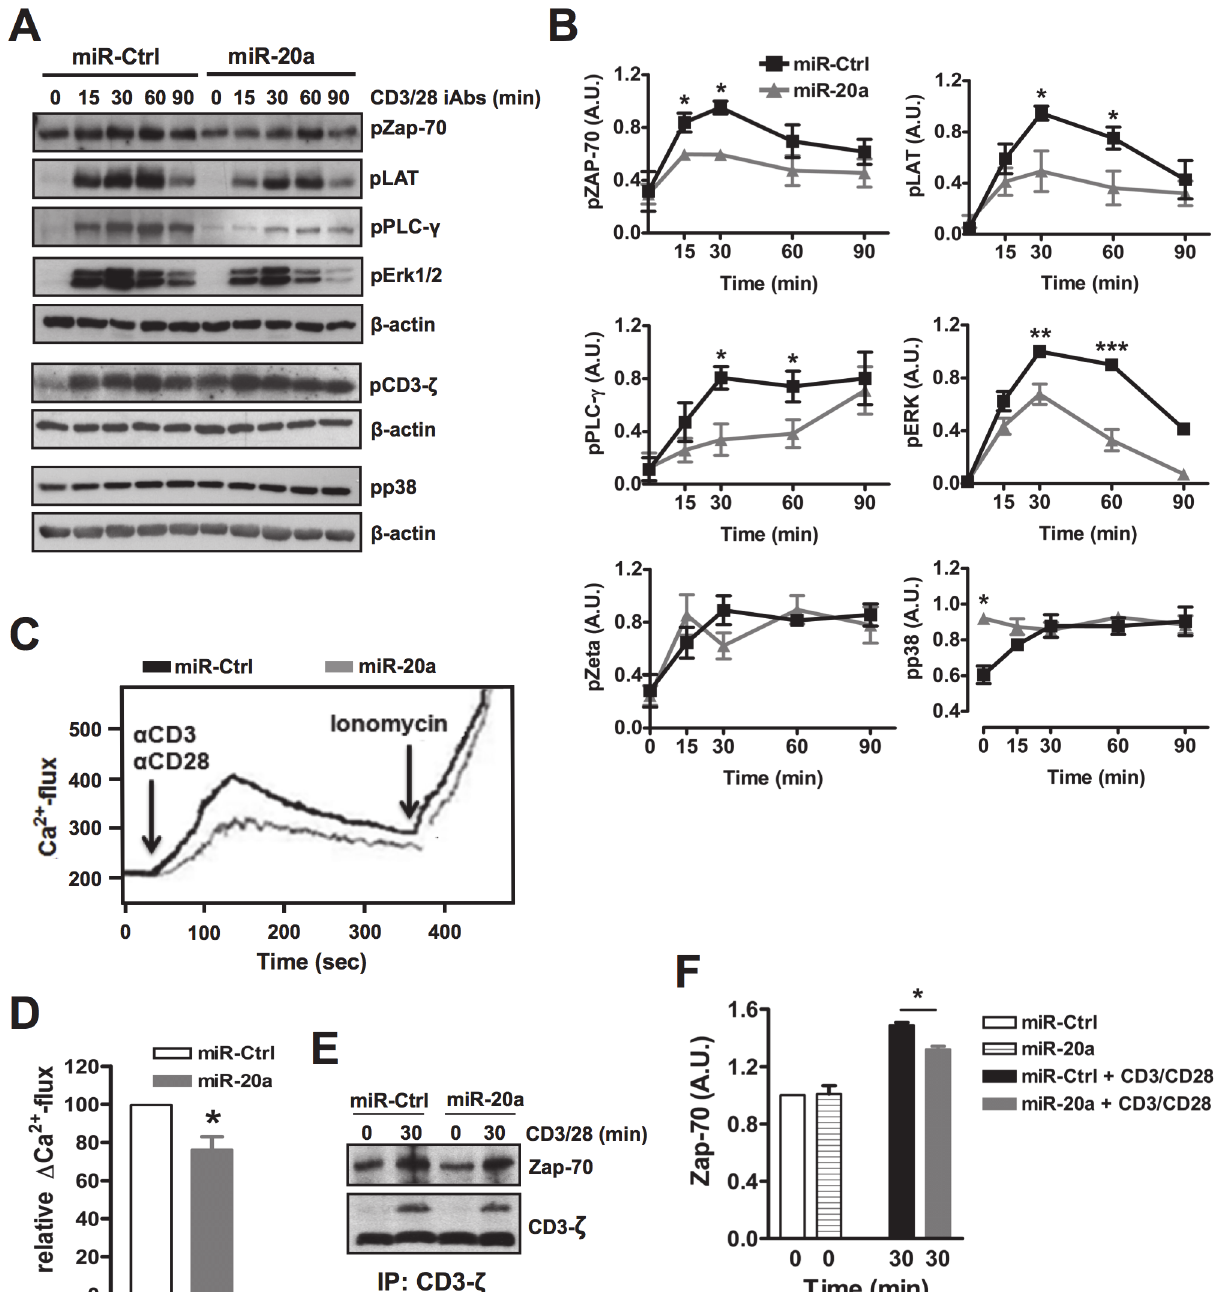
Fig 2. miR-20a inhibits TCR-mediated signaling. Human na ï ve CD4 + T cells were transfected with plasmids encoding either miR-20a or miR-control (miR-Ctrl) and cultered for 16 hours. (A) Cells were stimulated with microbeads coated with CD3 and CD28 mAbs (iAbs) for the indicated time periods. Subsequently, lysates were analyzed by immunoblotting using the indicated Abs. Bands in (A) were quantified using the ImageQuant software and values were normalized to the corresponding β -actin signal. Graphs in (B) show the phosphorylation levels of the indicated molecules as arbitrary units ± SEM of at least 4 independent experiments. (C) CD4 + T cells were incubated with Indo-1AM, stimulated with CD3 and CD28 mAbs, and Ca ++ flux was measured by flow cytometry. Ionomycin is used to induce maximum Ca ++ flux. Graph in (D) shows quantification of Ca ++ flux expressed as arbitrary units ± SEM of at least 3 independent experiments. (E) CD4 + T cells were stimulated with iAbs for the indicated time periods. Subsequently, cell lysates were prepared and CD3 ζ immunoprecipitations were analyzed by immunoblotting using the indicated Abs. Bands in (E) were quantified as described above. Graph in (F) shows the levels of CD3 ζ -associated Zap-70 as arbitrary units ± SEM of 2 independent experiments. Significat P values were done by using Student ’ s t Test. ( * , P < 0.05; ** , P < 0.01; *** , P < 0.001).